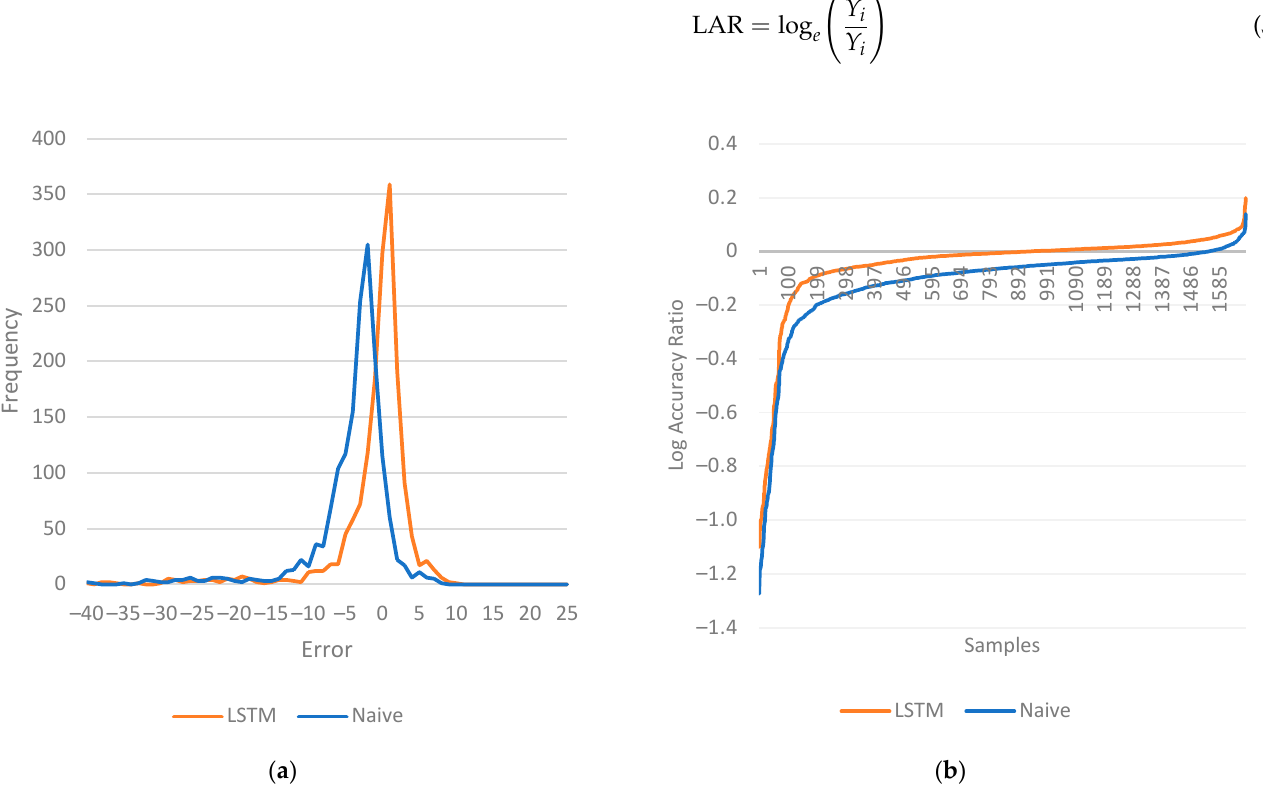
Figure 13. initial_values dataset. ( a ) Estimation error. ( b ) Log accuracy ratio.